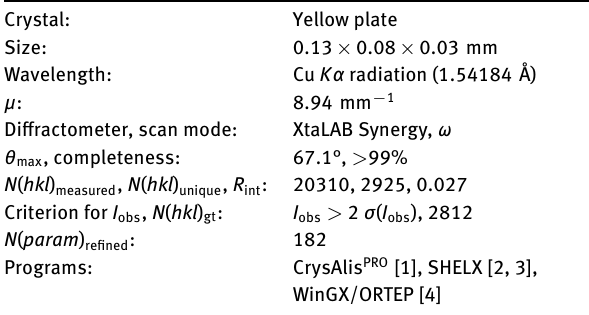
Table 1: Data collection and